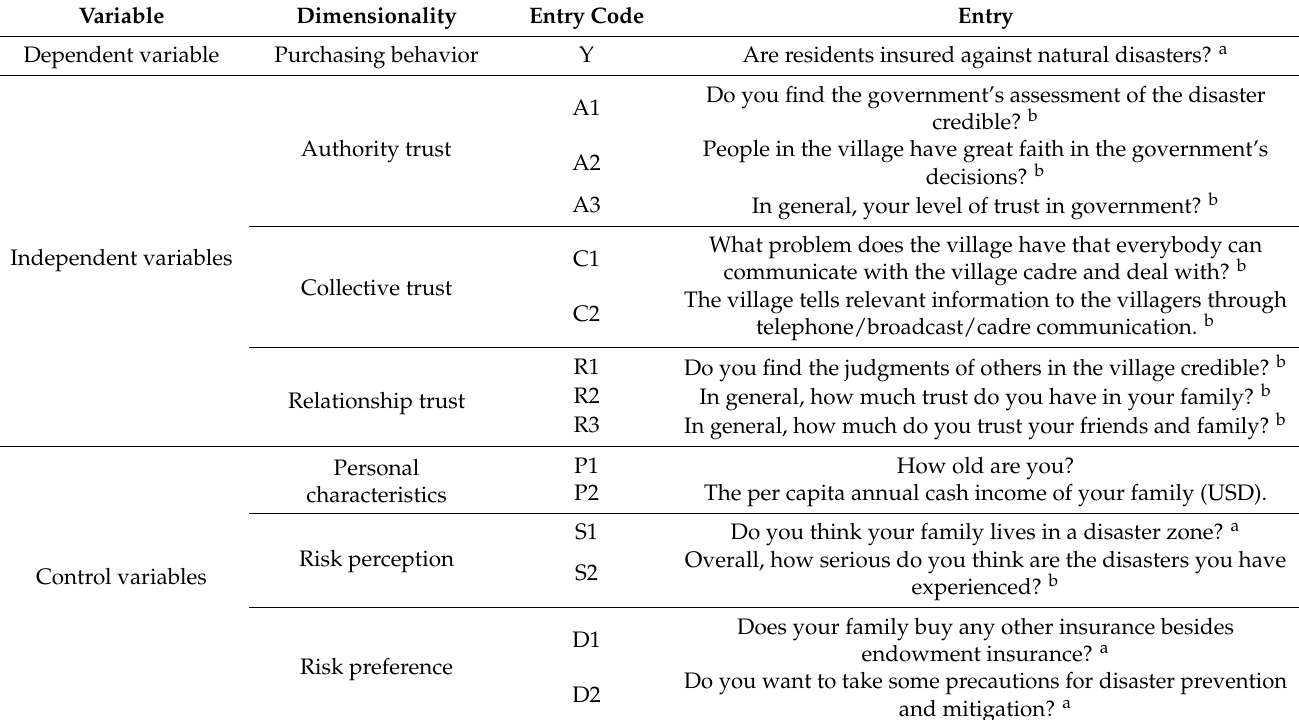
Table 1. Study variable setting and data